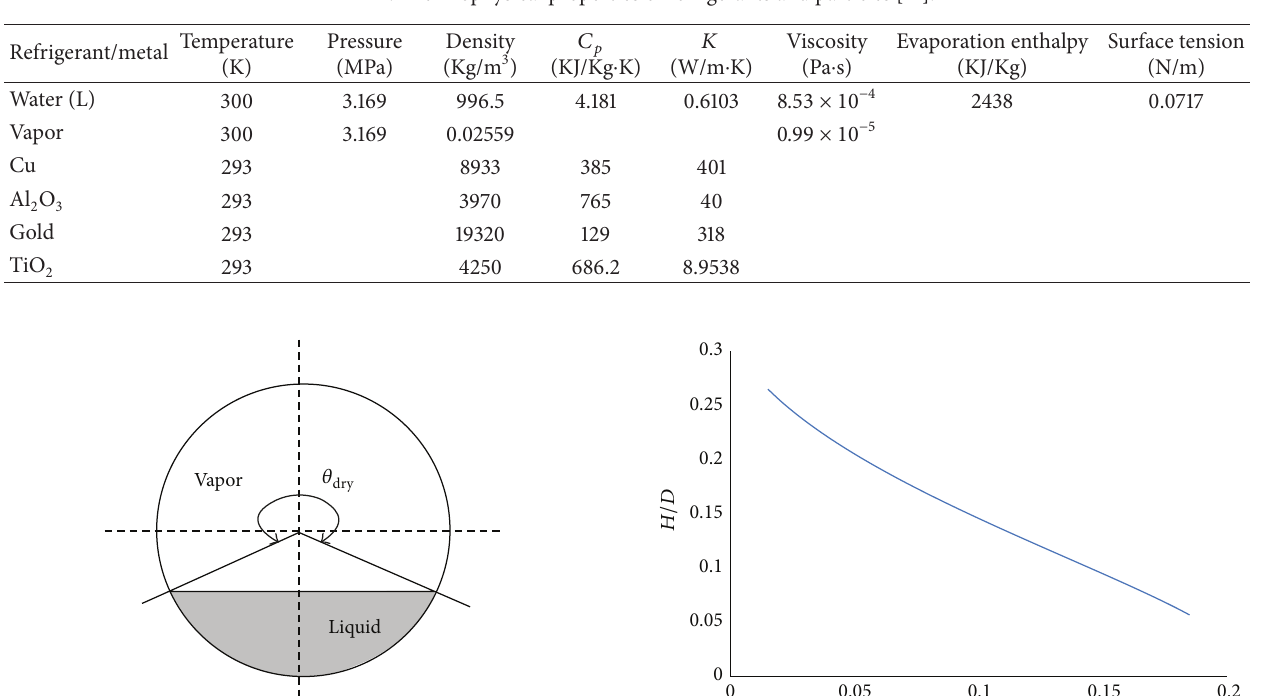
Table 1: Thermophysical properties of refrigerants and particles [14].